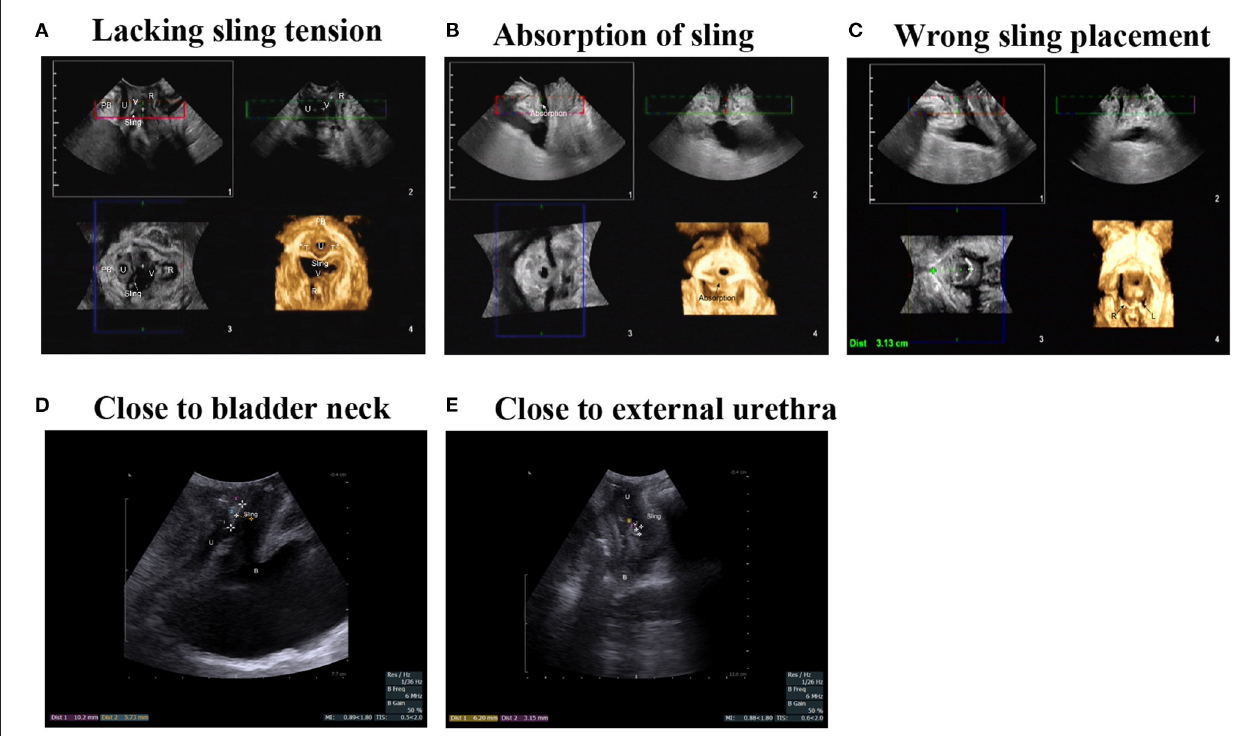
FIGURE 3 | Failed transobturator MUS procedures with various reasons. (A) Insufficient urethral compression resulted from a lack of sling tension. (B) Absorption of absorbable sling leads to the weakening of urethral support. (C) The left TOT sling puncture path failed to pass through obturator. (D) Poor position of sling closing to bladder neck. (E) Poor position of sling closing to external urethra.